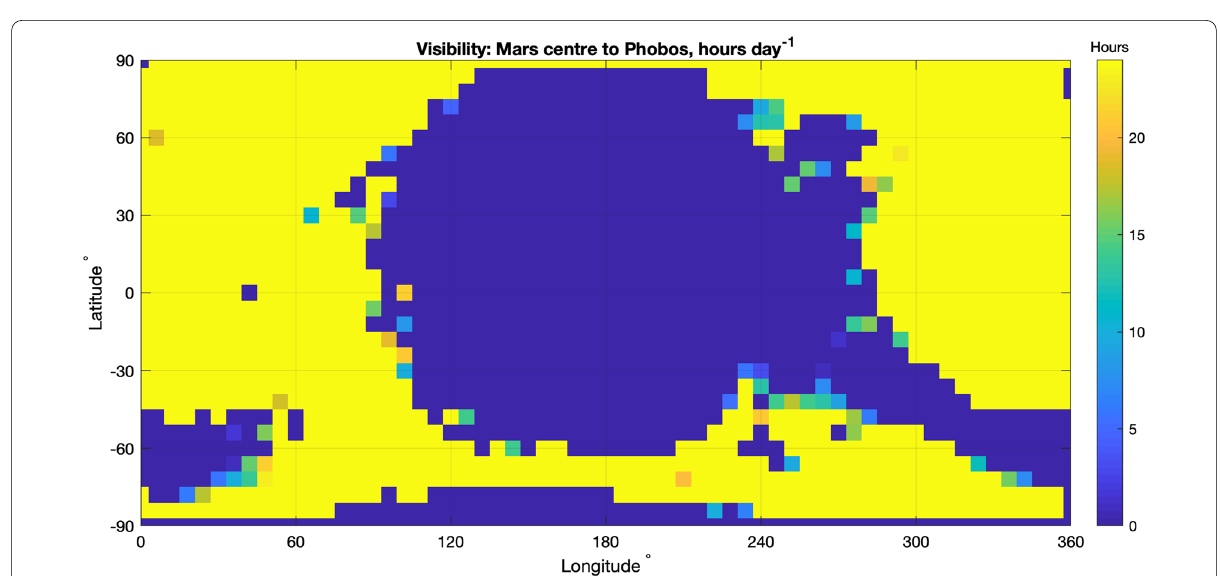
Fig. 5 Map of Phobos. Mars centre to Phobos visibility hours per day averaged over the period (1 Jan 2030 – 18 Nov